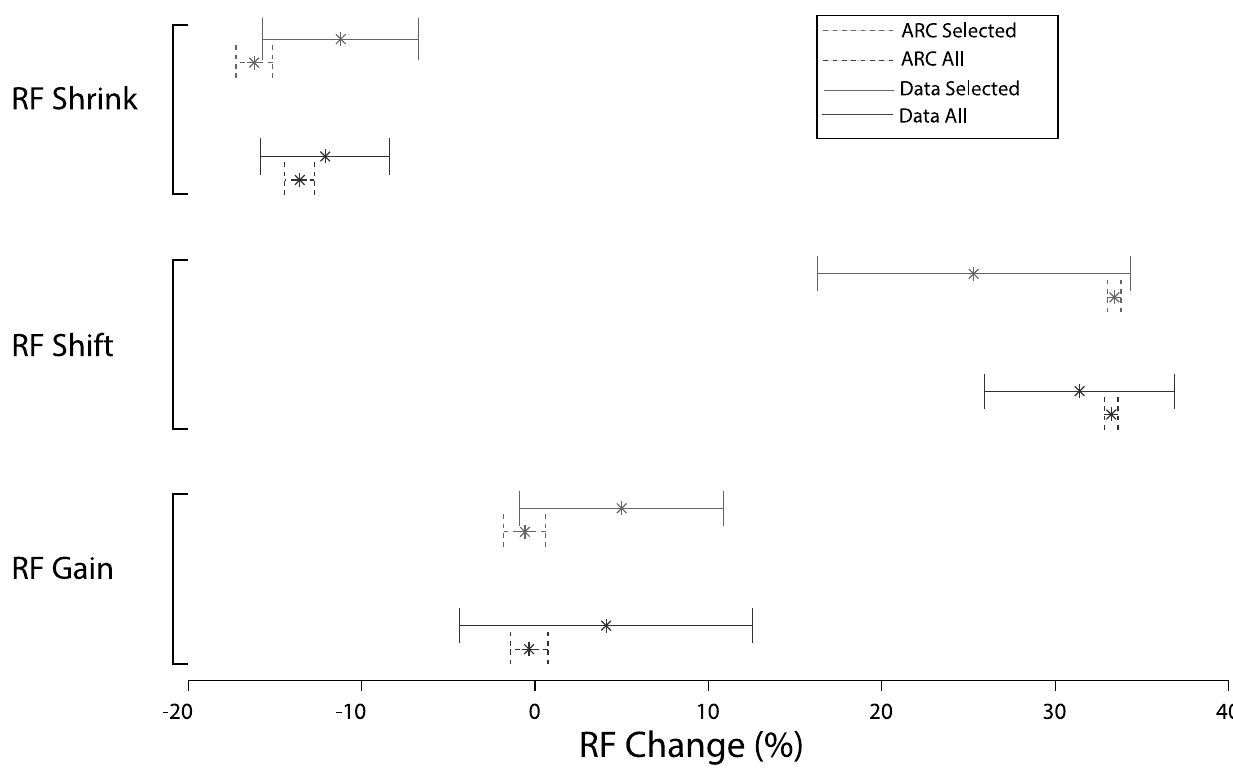
Figure 6. Summary of attentional effects (mean and 95% CI) for 100 simulated monkeys (dashed lines) and results reported by [3] (solid lines). Bars on the top for each effect are selected pairs and the lower below are from the entire sample.